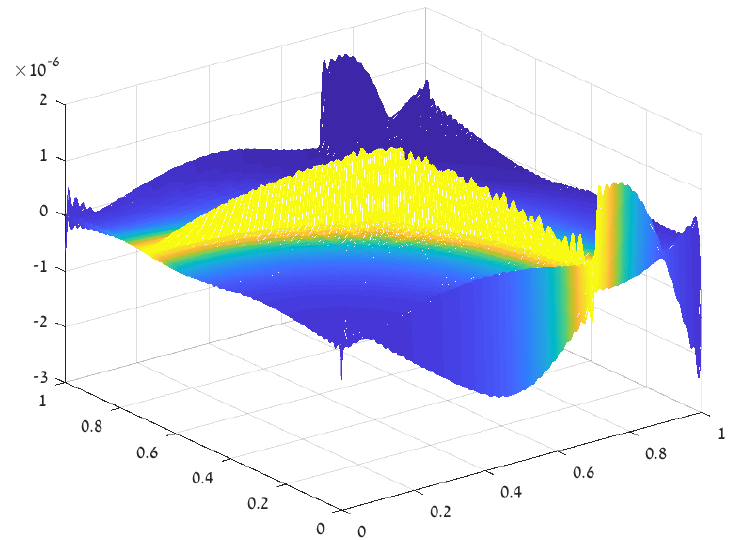
Figure 12. First order x -direction differences of a truncated Fourier sum—notice the relatively high values at the boundary and near the singularity